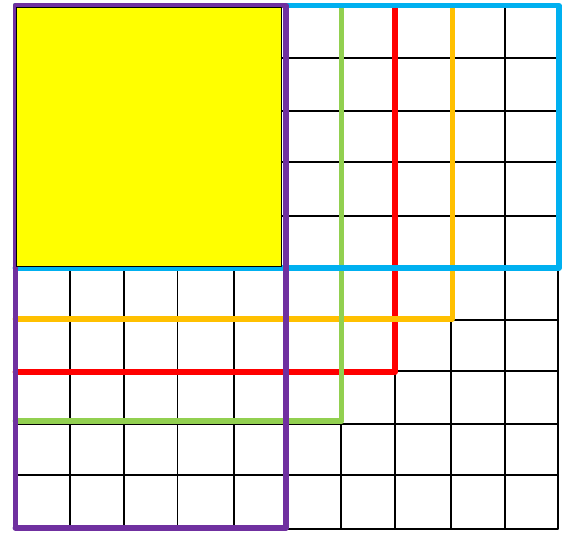
Figure. 3. The illustration of DATT. FATT is applied to all pixel subsets (blue, orange, red, green and purple) and if all the apertures return detections, the pixels in the yellow part are considered as true